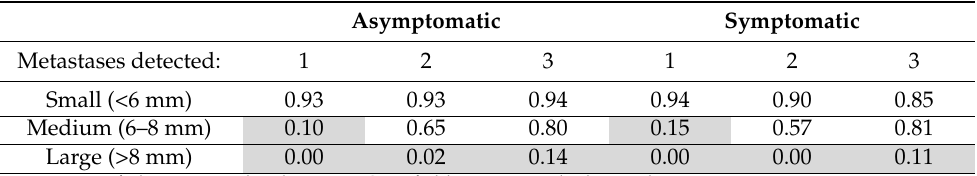
Proportions of oligo+ per risk sub-group. Grey fields represent the low-risk group. Table A11. Proportion of oligo+ within patients with detected oligo-metastases in the Correlation ρ = 0.5 scenario.